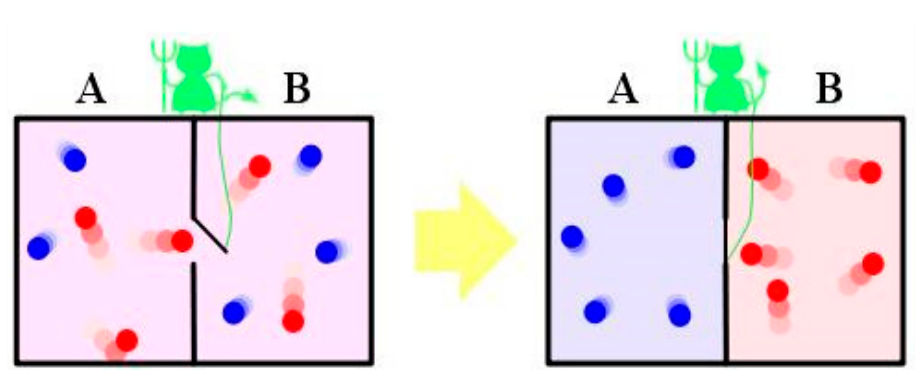
Figure 4. ( Left ) The demon (green) observes the moving molecules in a gas and separates those moving fast (red dots) from those moving slow (blue dots) by the effortless opening of a small gate. ( Right ) A temperature gradient is established against the second law. The image «Maxwell's demon», by Htkym, is under license CC BY-SA 3.0, Wikimedia Commons.